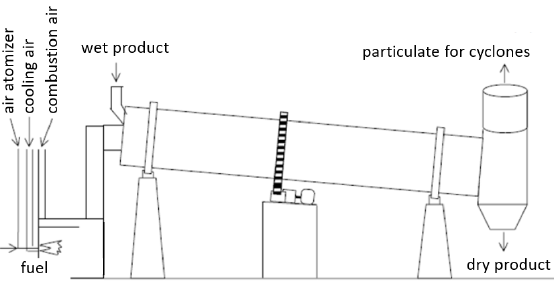
Figure 11. Rotary dryer [58].